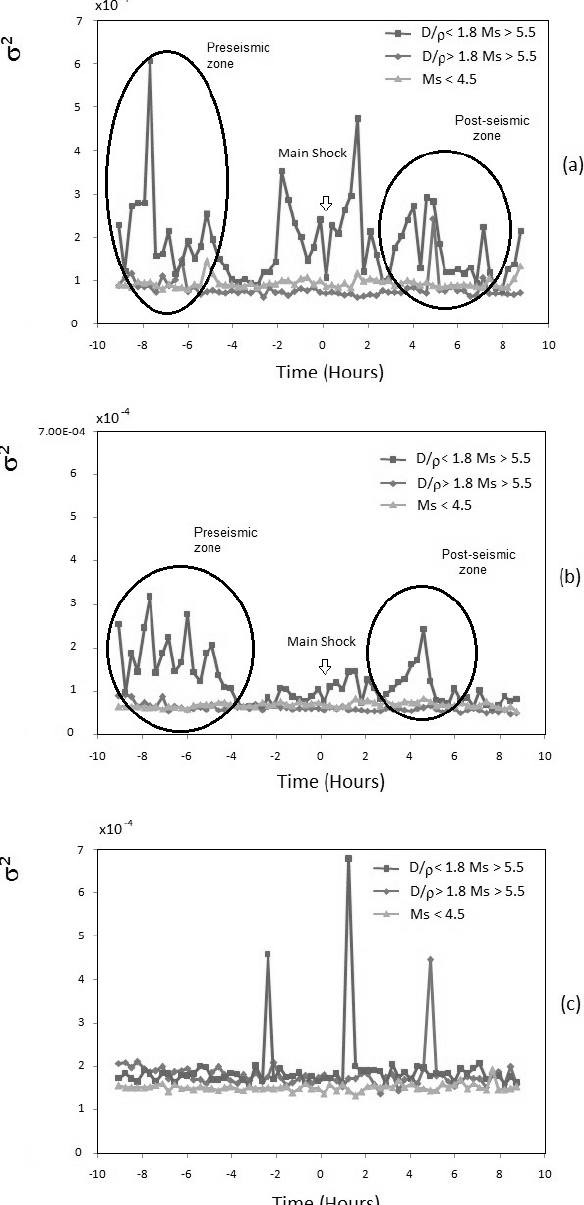
Fig. 4. Variance of the DWT corresponding to the D1 level for the three geomagnetic components; Bx (a) , By (b) , and Bz (c) .